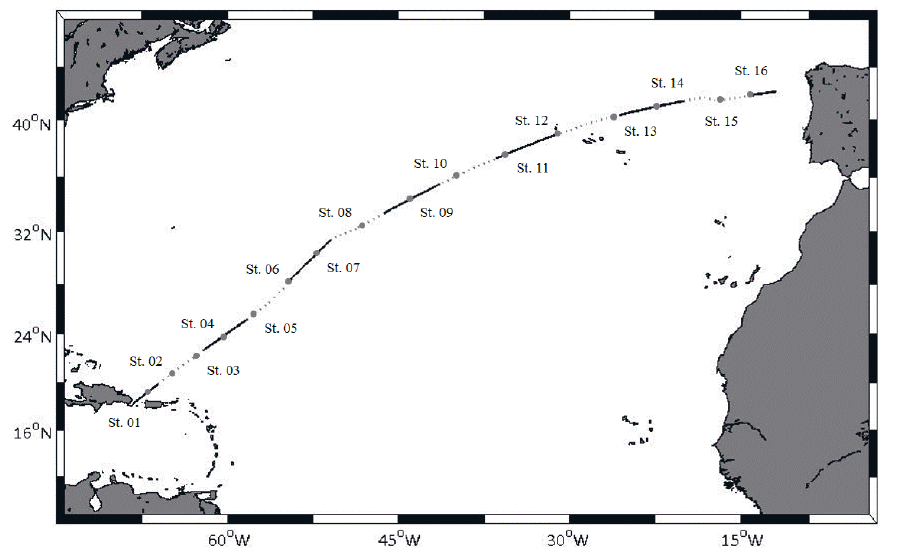
Figure 1. Transect of the study cruise on board the Research Vessel “Sarmiento de Gamboa”, and locations of sampling stations. Each dotted and solid line corresponds to 500